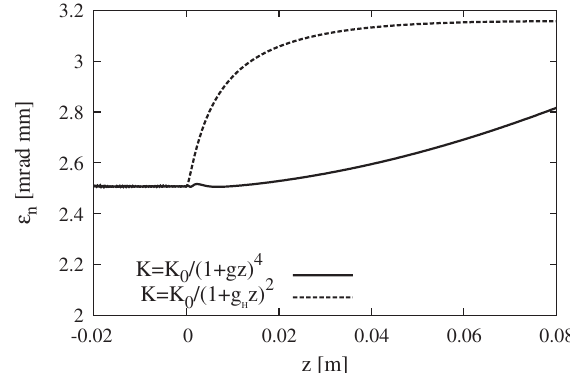
FIG. 6. Development of the transverse emittance for the field profiles shown in Fig.